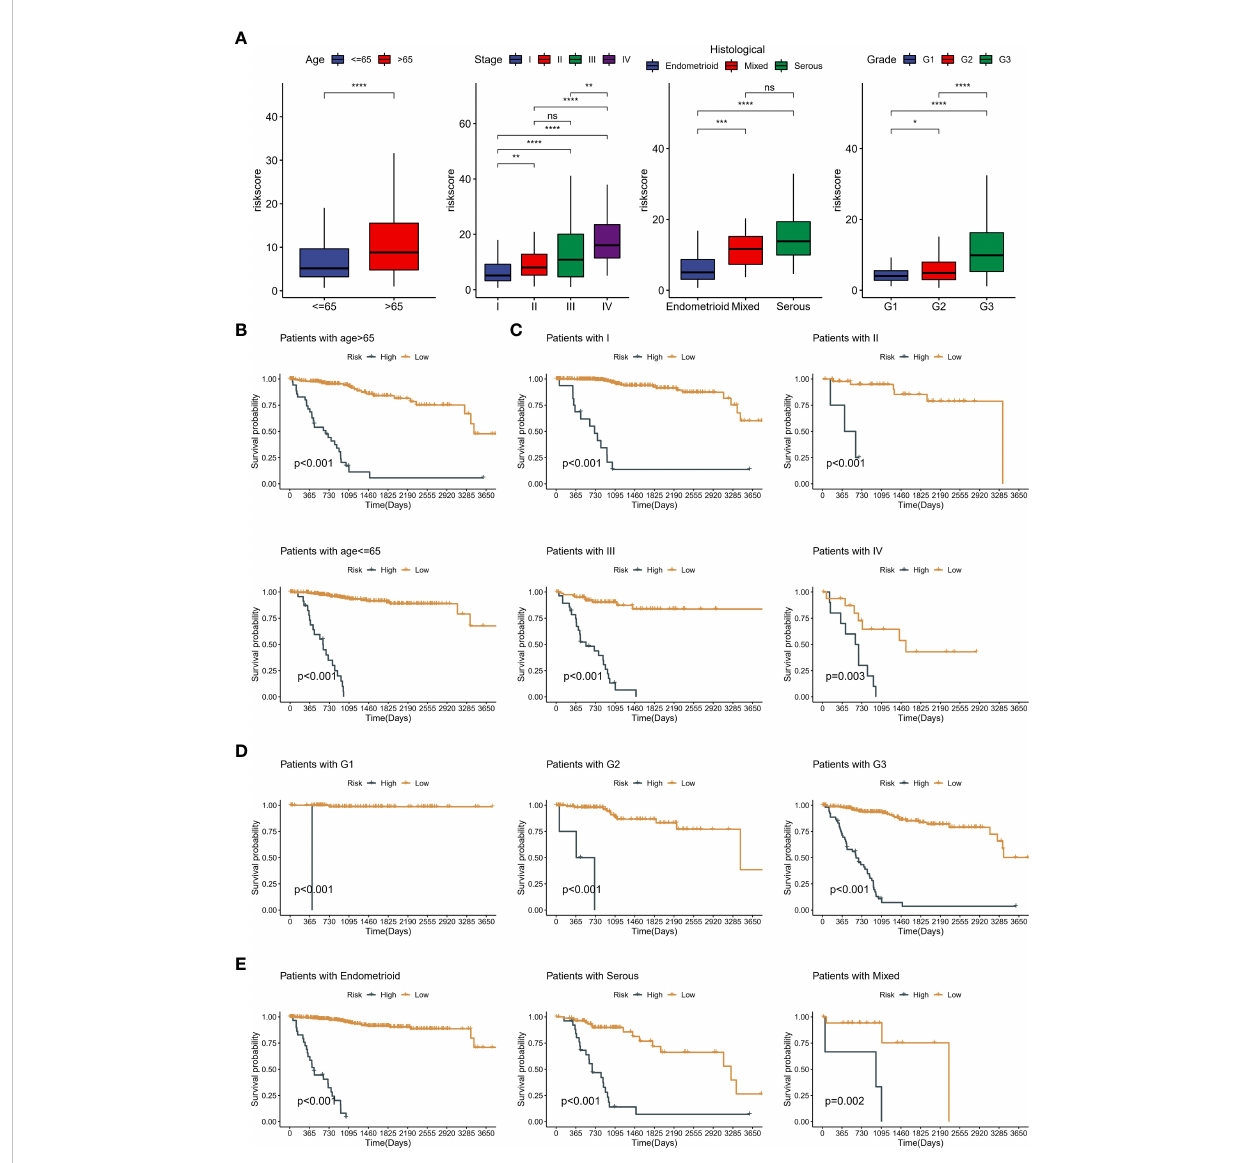
FIGURE 7 Clinical signi fi cance of neddylation-related risk score. (A) The differences in risk scores across clinical subgroups, including age, grade, FIGO stage and pathologic types. (B) Kaplan-Meier analysis of different age subgroups. (C) Kaplan-Meier analysis of different FIGO stage subgroups. (D) Kaplan- Meier analysis of different grade subgroups. (E) Kaplan-Meier analysis of different pathologic types subgroups. ns, no statistical signi fi cance; *p < 0.05, **p < 0.01, ***p < 0.001, ****p <